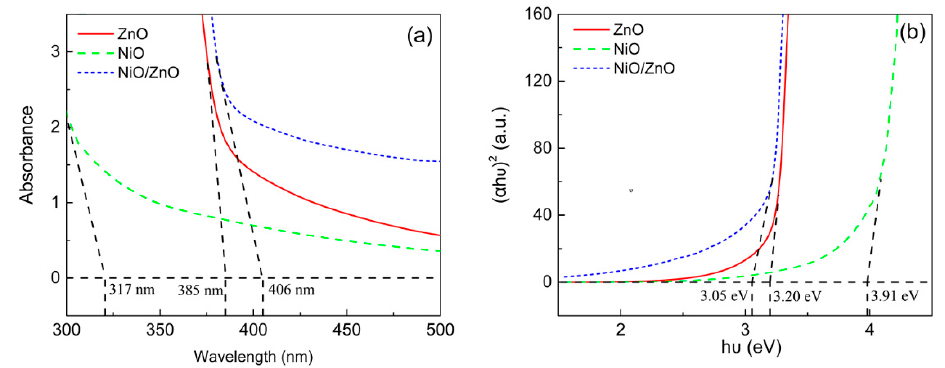
Figure 5. (a) UV-visible absorption spectra and ( b ) plot of ( α h υ ) 2 vs. h υ of ZnO NRs, NiO NSs, and NiO/ZnO